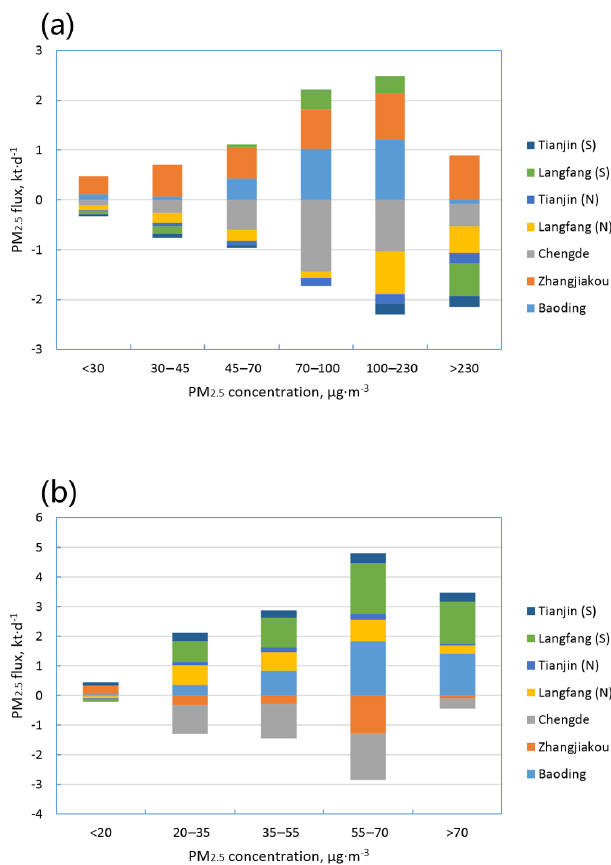
Figure 8. PM 2 . 5 average flux in different degrees of pollution in (a) January and (b)